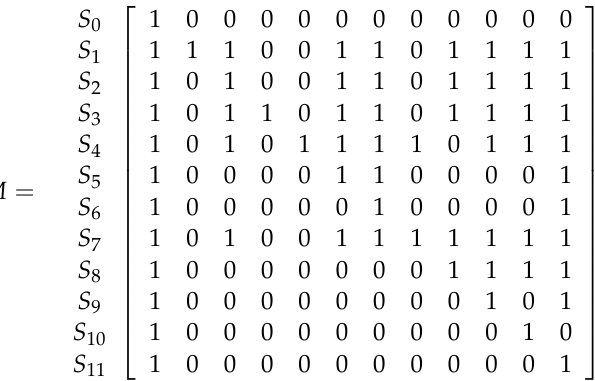
Figure 2. Logical relationship of the factors influencing farmers’ willingness to maintain the SLCP. Based on Figure 2 and Equation (3), the adjacency matrix R of each factor influencing farmers ’ willingness to maintain the SLCP can be obtained (due to space limitations, the results are not presented here). Furthermore, based on Equation (4) and by using